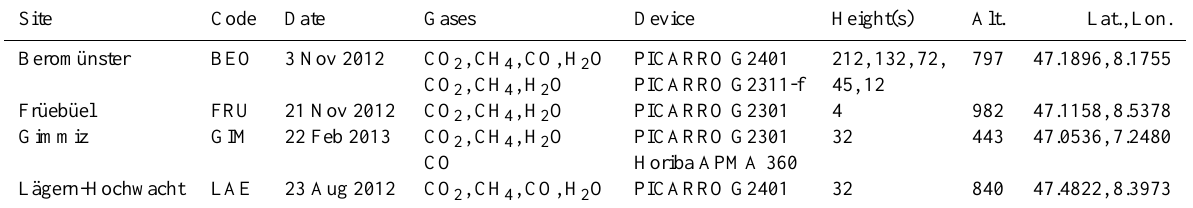
Table 1. Details of the four measurement sites of the CarboCount CH network. From left to right: the site name, the site code, measurement commencement date, the measurement height(s), measured trace gases, the site’s altitude (ma.s.l.), and the geographic site